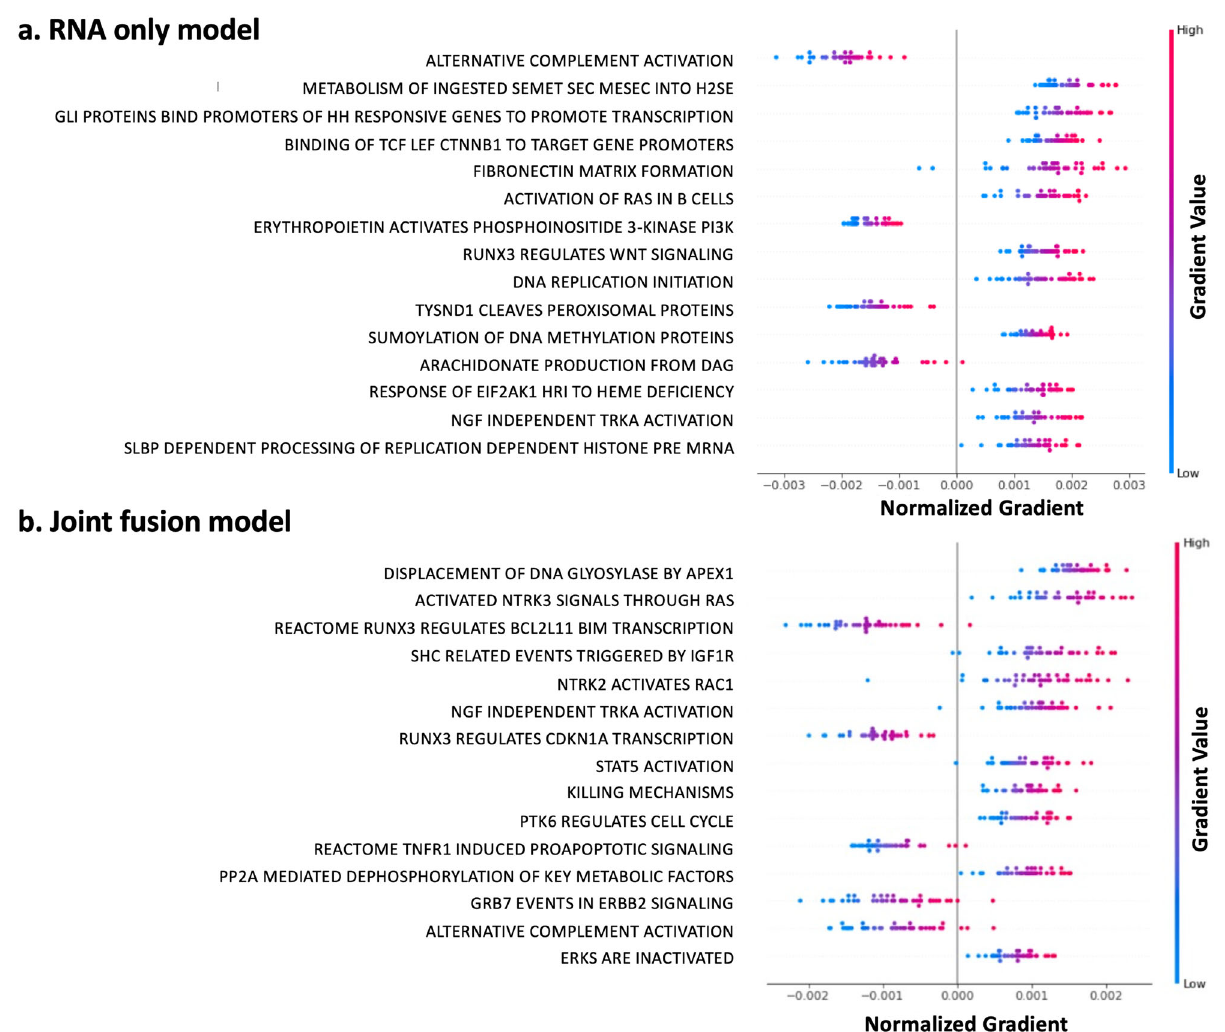
Fig. 6 Visualization of pathway importance with respect to survival predictions for the pediatric glioma cohort. Pathways are ranked from top to bottom based on the sum of the absolute gradients across all samples. Negative gradients contribute to a lower risk score, while positive gradients lead to a higher risk score. a Top 15 pathways of the unimodal gene expression model (RNA only). b Top 15 pathways of the multimodal joint fusion model (histopathology + RNA